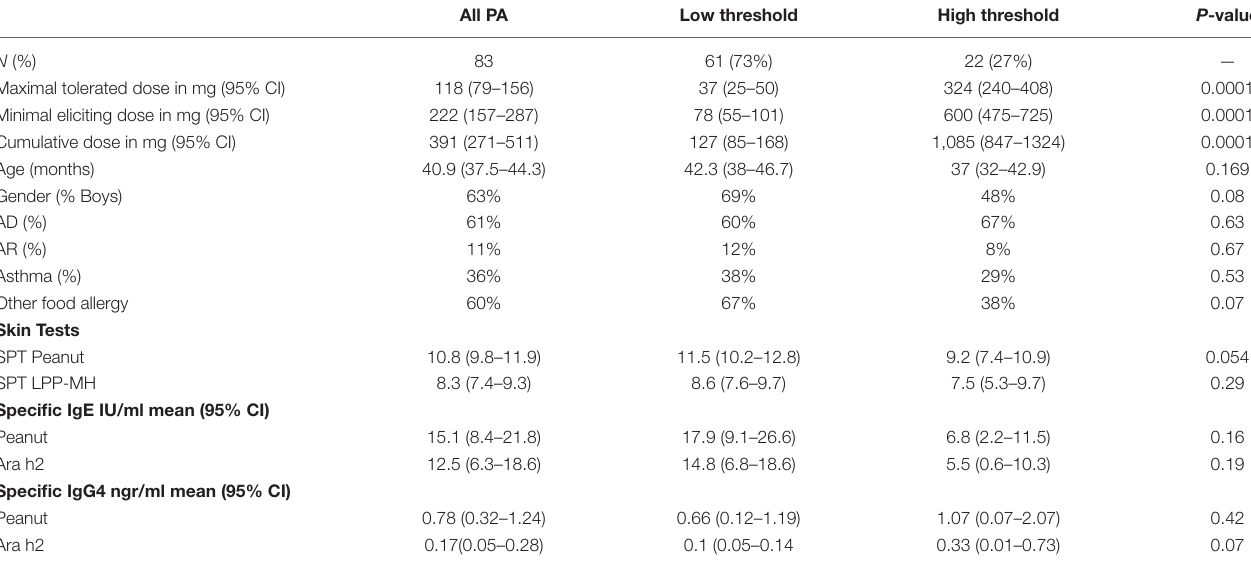
TABLE 4 | Maximal tolerated doses and minimal eliciting doses for high and low threshold peanut allergic preschoolers. All PA Low threshold High threshold P